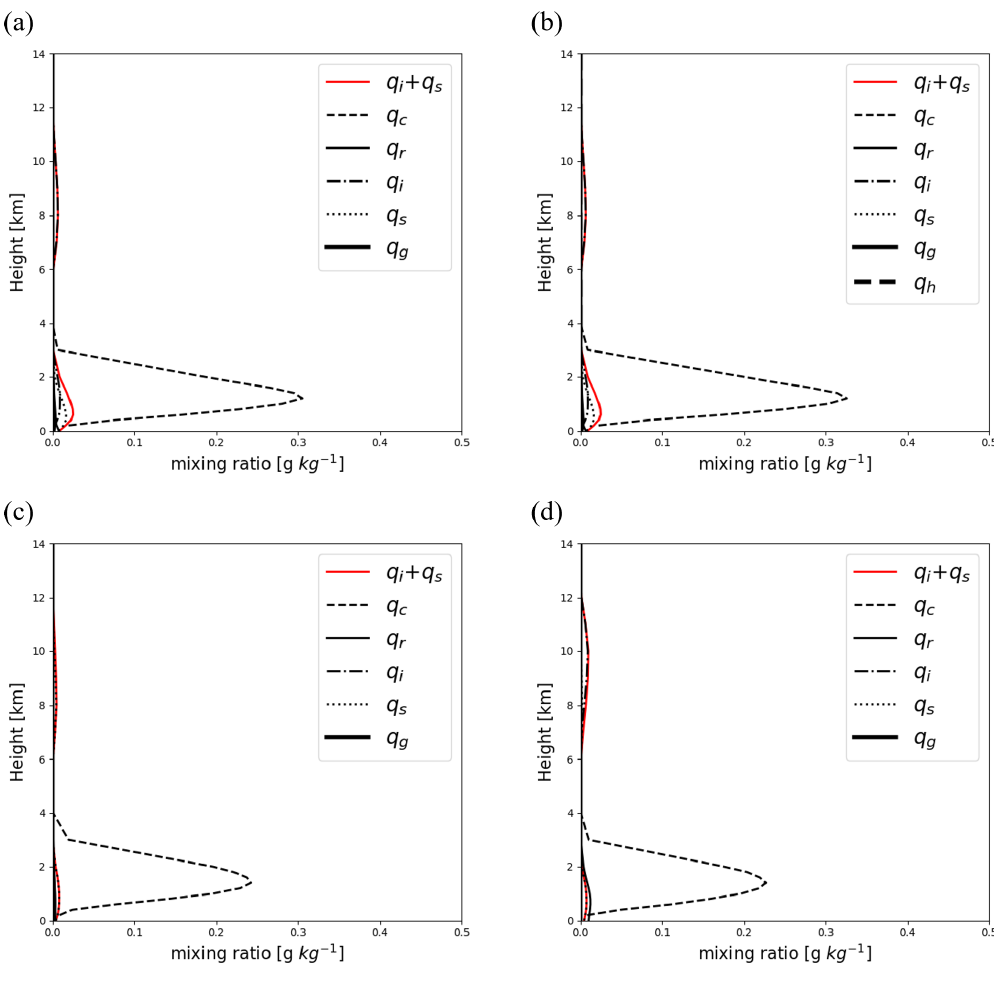
Figure 12. The same as Fig. 8 but representing the results for case